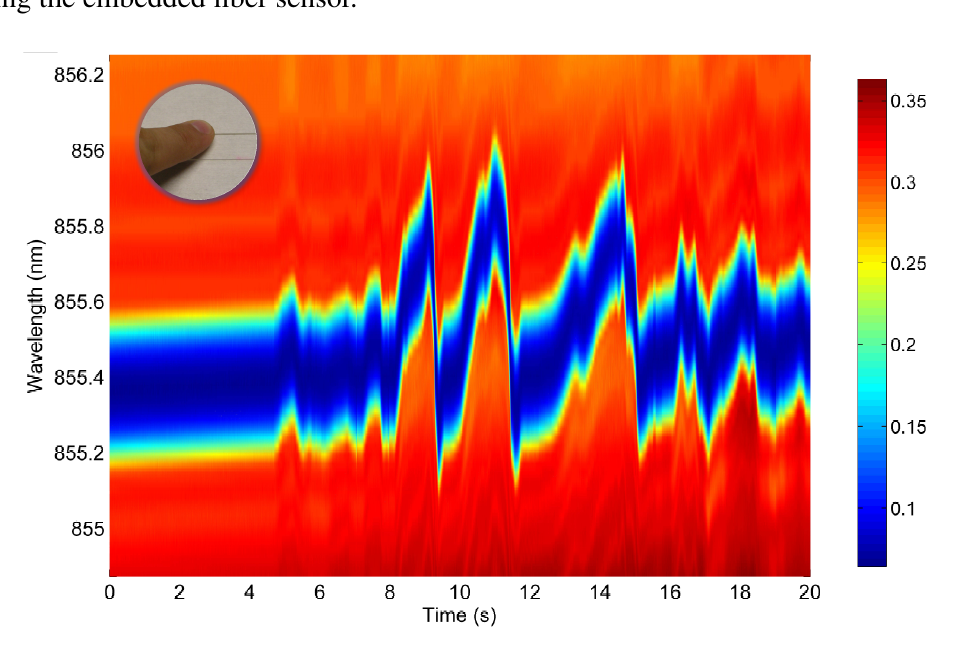
Figure 15. Tactile sensing demonstration: relative wavelength intensity variations when touching the embedded fiber sensor.